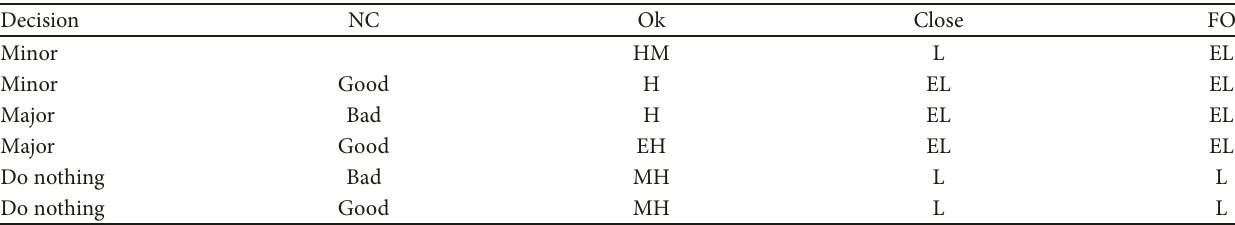
Table 5: Conditional probabilities of failure modes.